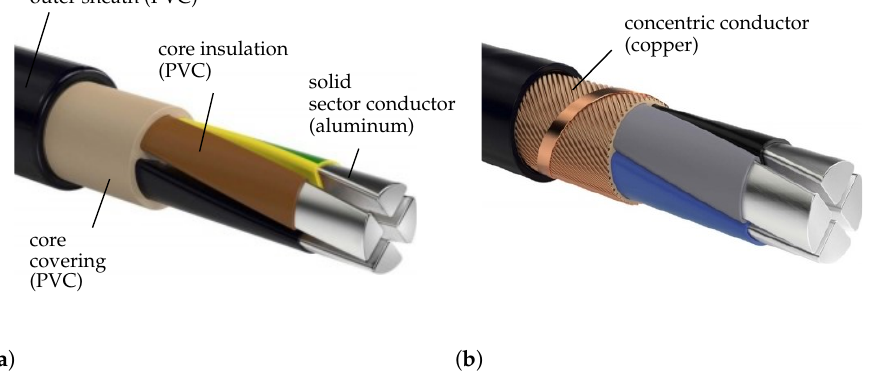
Figure 1. Standard cable types in German low voltage (LV) grids [7]. ( a ) NAYY-J cable type [8]. ( b ) NAYCWY cable type